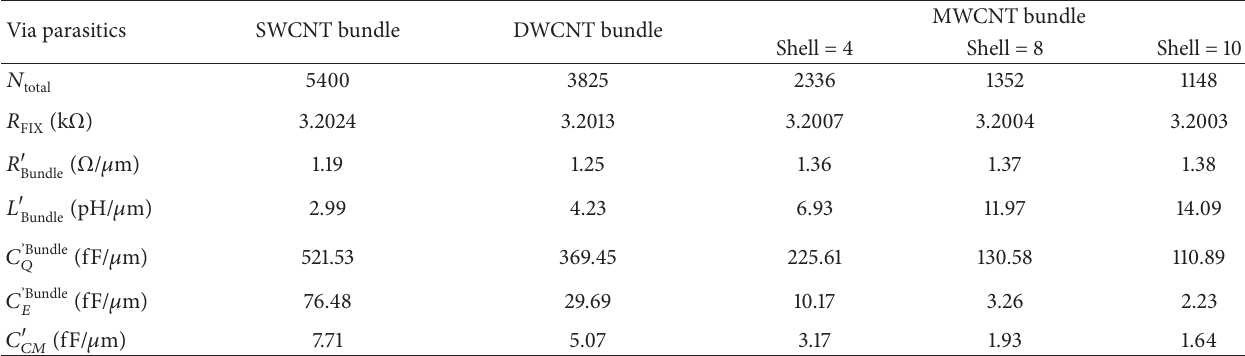
Table 1: Via parasitics associated with different CNT bundled TSVs.